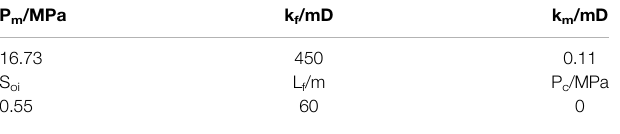
TABLE 2 | Table of basic parameters of single well numerical simulation